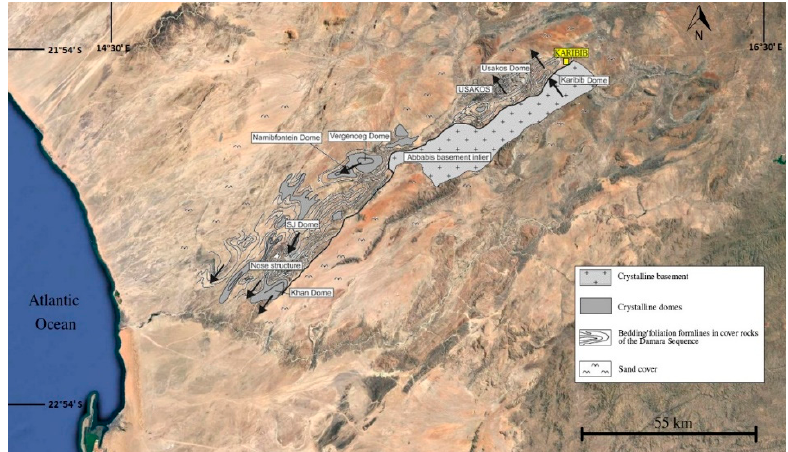
Figure 2. Schematic map showing the northeast trending dome structures covered by the geological map, by [40]. The gneisses and/or the Pan-African granitoids constitute the cores of the dome structures, whereas the surrounding supracrustals of the Damara sequence are draped around the domes. The solid black arrows indicate the tectonic transport direction for domes [41–44] and the Karibib district in the northeast. The yellow rectangle indicates the area where the marble quarries are located. Deformation and metamorphism have not completely obliterated structures and textures inherited from sedimentary environments, so the planar surfaces due to tectonic deformation overprint the contacts between lithofacies